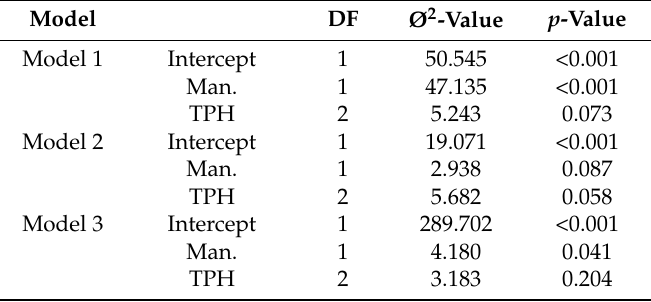
Table 6. Generalized linear mixed model, and linear mixed model analysis of deviance table (Type III Wald chi-squared tests) for analysis of solid wood product potential (Model 1), proportion of product- defining defects (Model 2), and heights of product-defining defects (Model 3). Models constructed